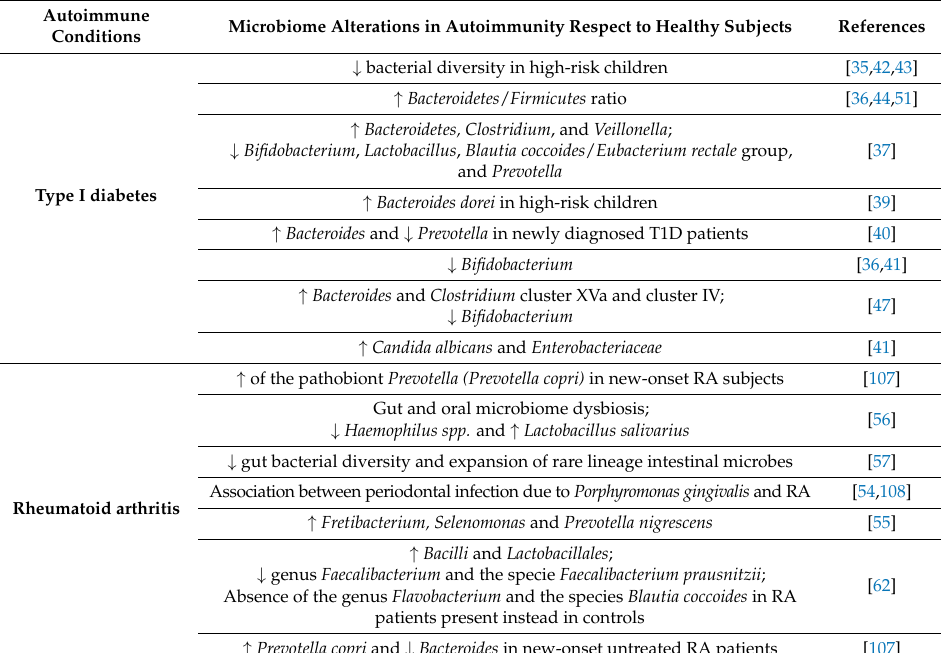
Table 1. Microbiome alterations in different autoimmune conditions respect to healthy